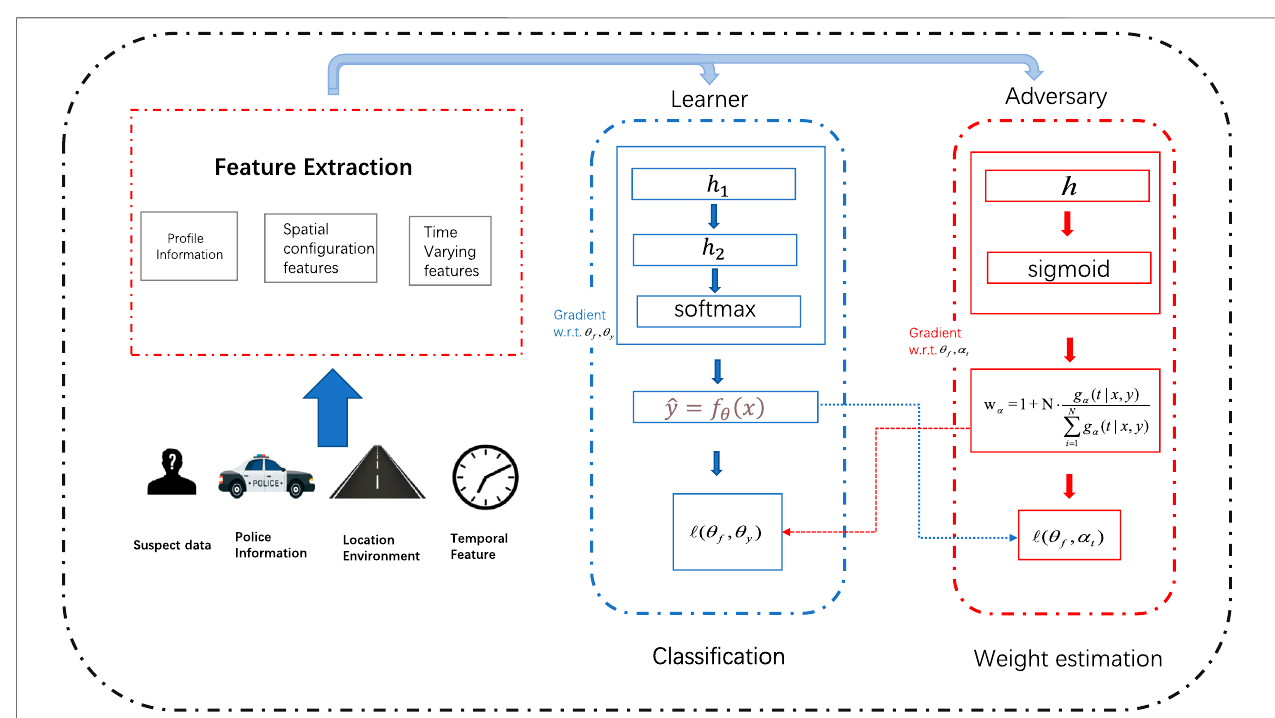
FIGURE 2 | Overview of our framework. We leverage the re-weighting framework to approximate an unbiased distribution. To better estimate the re-weighting score, we estimate a counterfactual distribution in the stop and frisk program, and propose an adversarial re-weighting method. The learner aims to learn the re- weighting score and adversary aims to train the classi fi cation